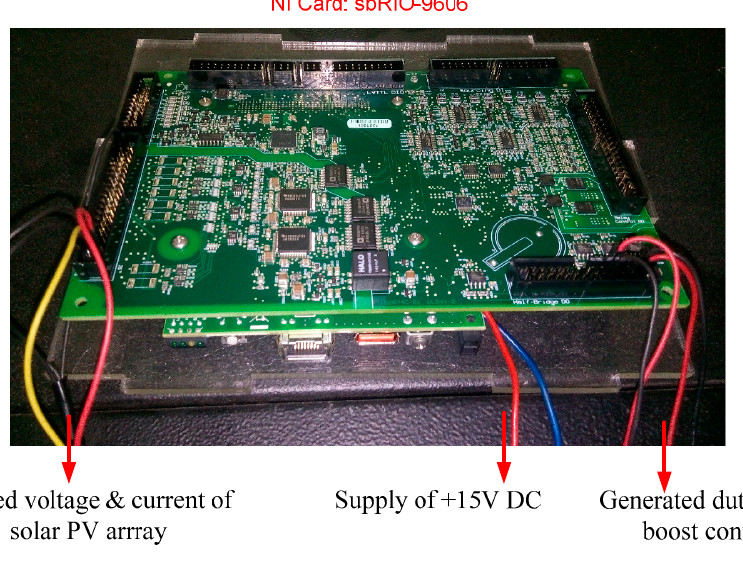
Figure 16. NI card: sbRIO-9606 connection diagram.